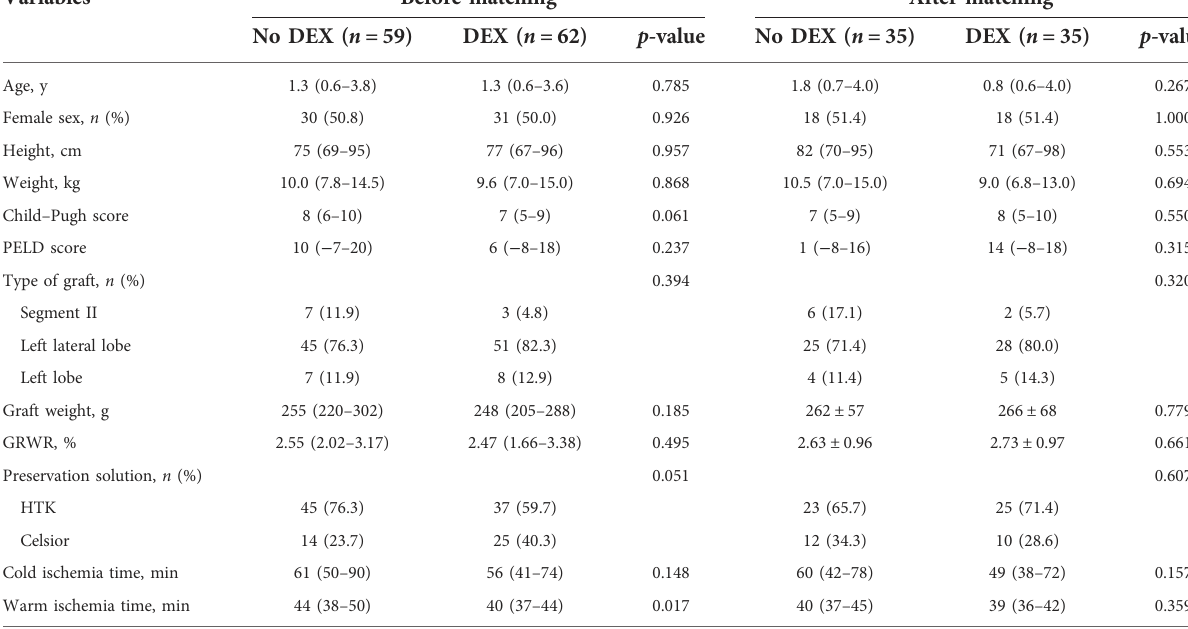
TABLE 1 Baseline characteristics of study patients before and after propensity score matching.